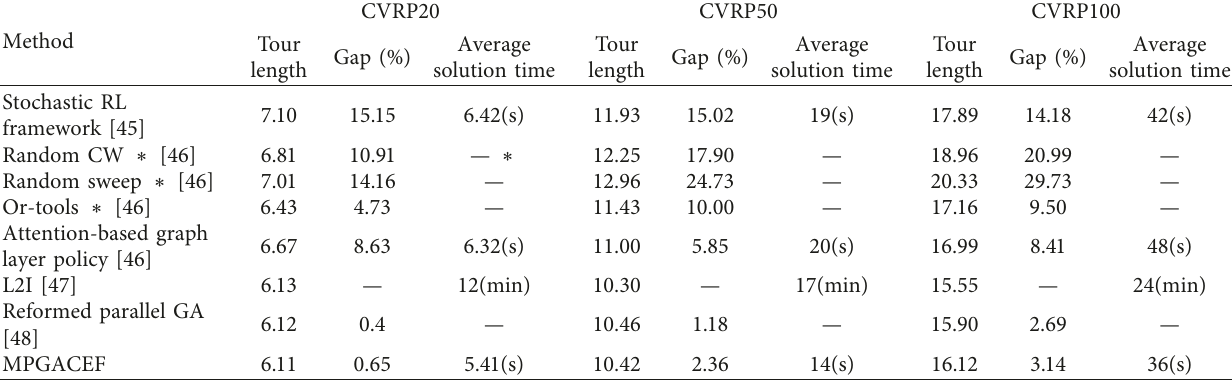
Table 1: The average tour length, gap percentage and average solution time of